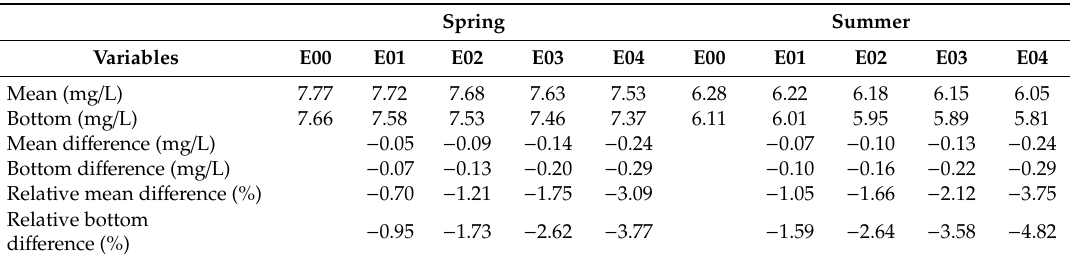
Table 3. The comparison of dissolved oxygen results of the numerical experiment of the channel deepening in the spring and summer